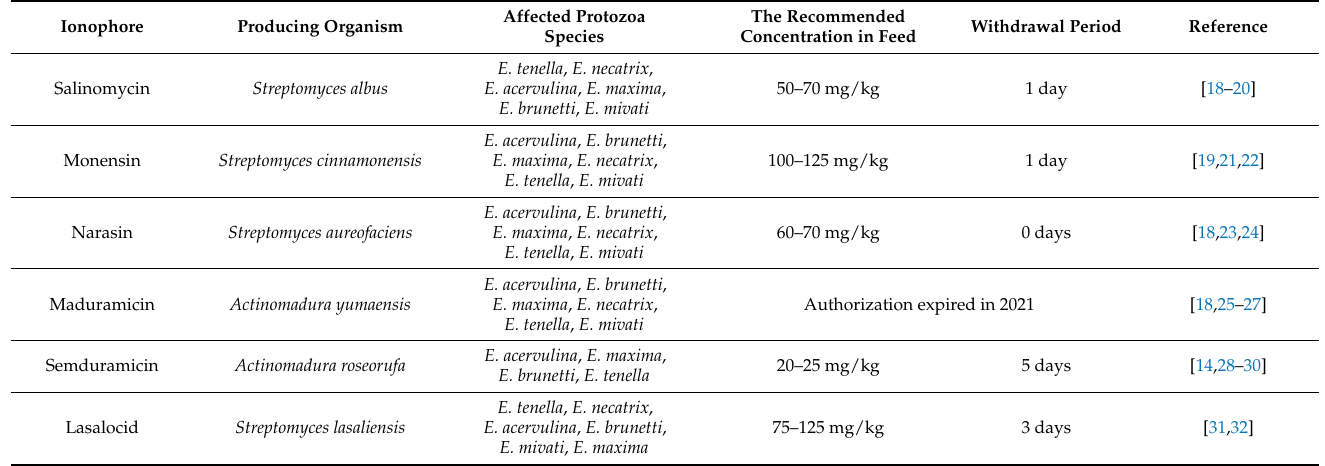
Table 2. Features of the ionophores. The recommended concentrations in feed and withdrawal periods are given according to European Union Register of Feed Additives, Edition 07/2022